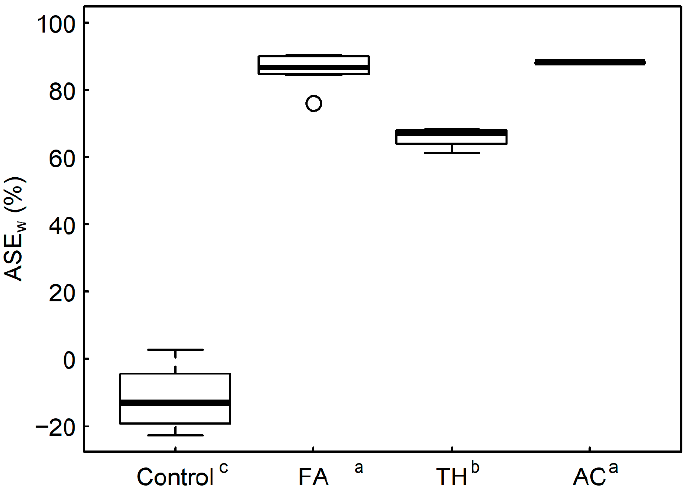
Figure 3. ASE w values for each wood type (calculated following 30 min soaking). Superscripted letters on the x -axis indicate significant differences according to Tukey’s HSD test (95% confidence level).